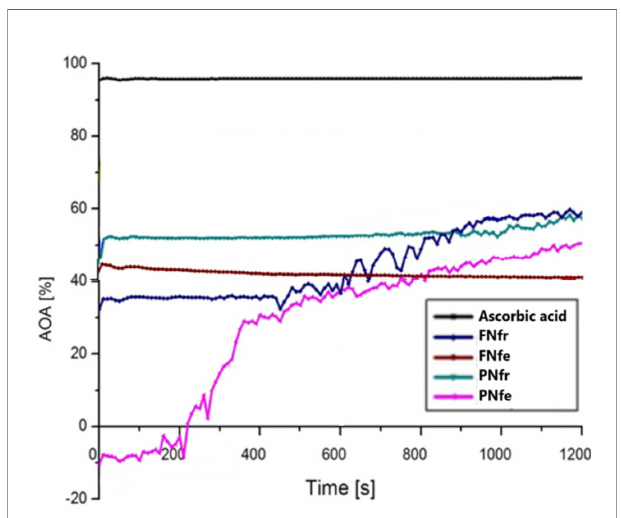
FIGURE 5 | Antioxidant activity evaluation with DPPH test. FNfe, Feteasca ̆ neagra ̆ fermented grape pomace extract; FNfr, Feteasca ̆ neagra ̆ fresh grape pomace extract; PNfe, Pinot noir fermented grape pomace extract; PNfr, Pinot noir fresh grape pomace extract.